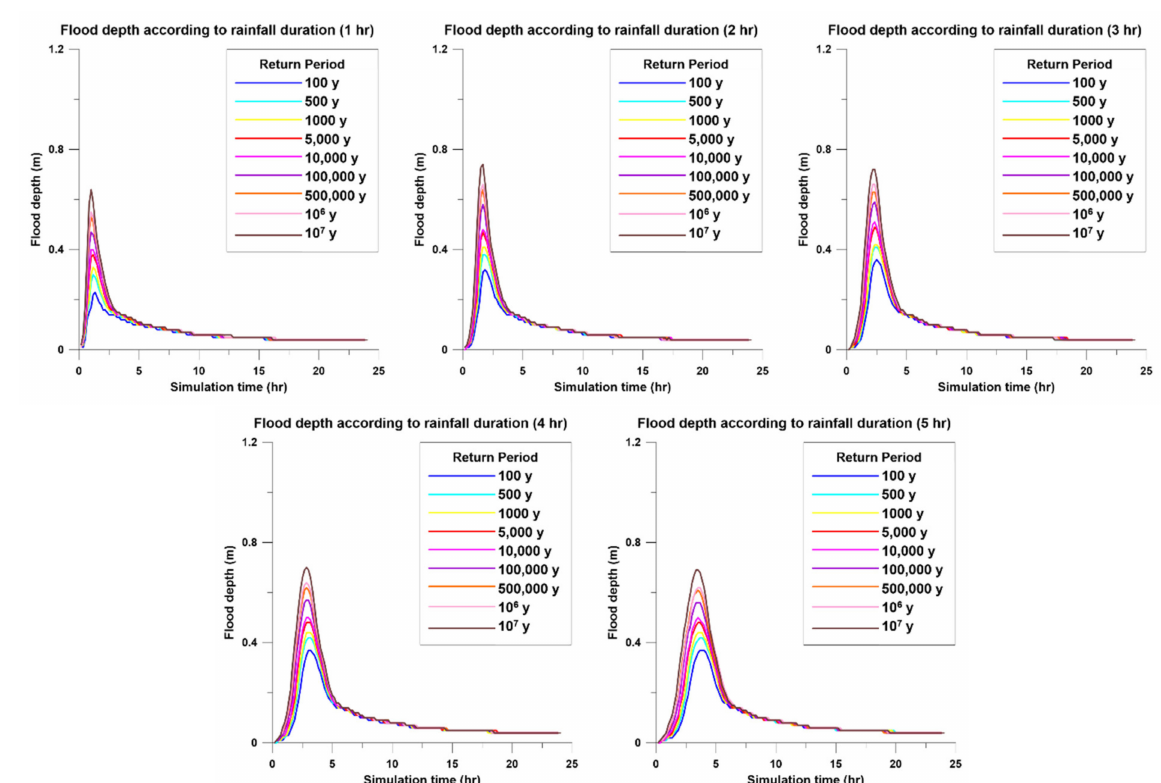
Figure 4. Inflow boundary conditions for grid no. 5274 (turbine building, NPP 2).